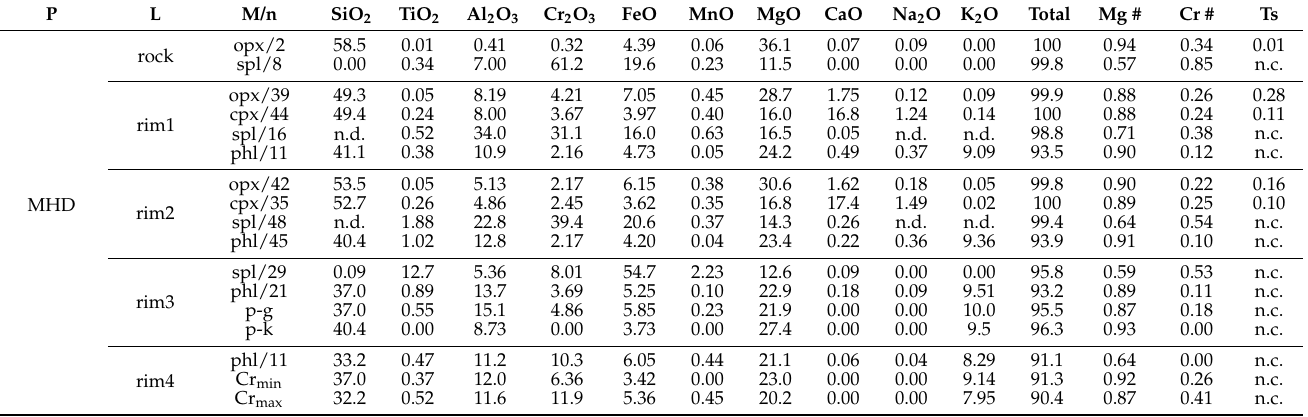
Table 2. Chemical compositions of primary (rock-forming) minerals of MHD, ShP, and Ecl mantle xenoliths and the same-named minerals and phlogopite in the different types of kelyphitic rims.